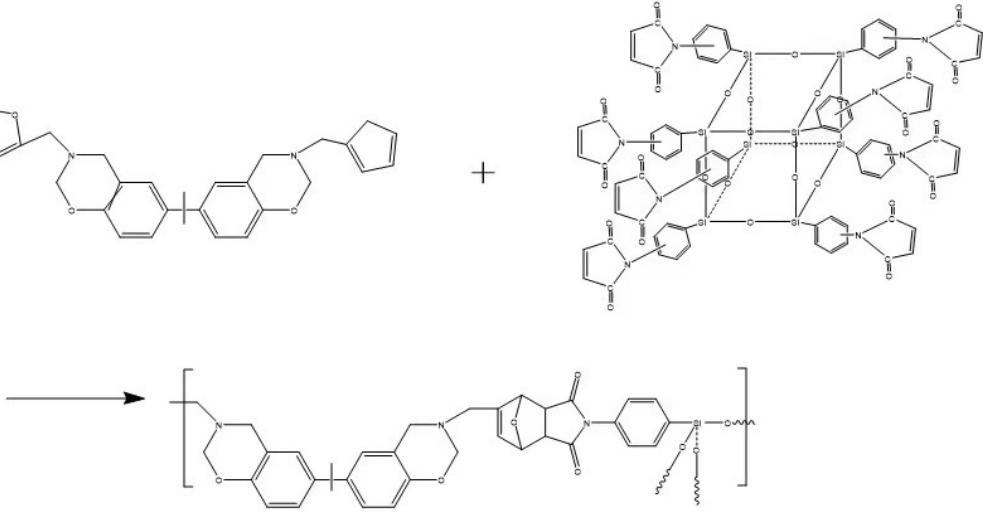
Figure 2. The reaction of OMPS and bisphenol A–furfuryl amine benzoxazine. A mixture of OMPS and bisphenol A–furfurylamine benzoxazine resin was